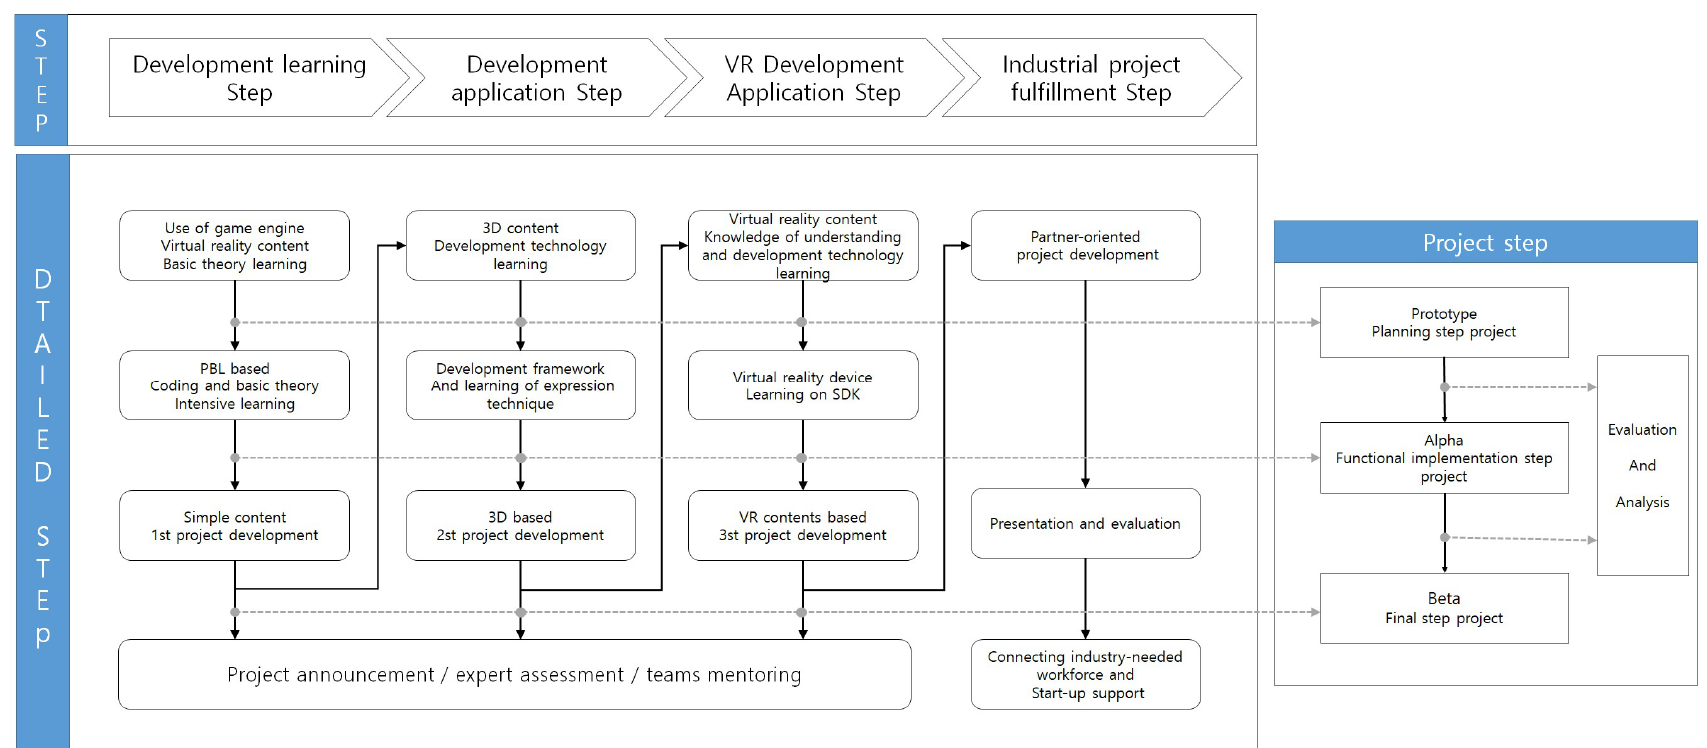
Figure 3. VR Contents Developer Educational Model.